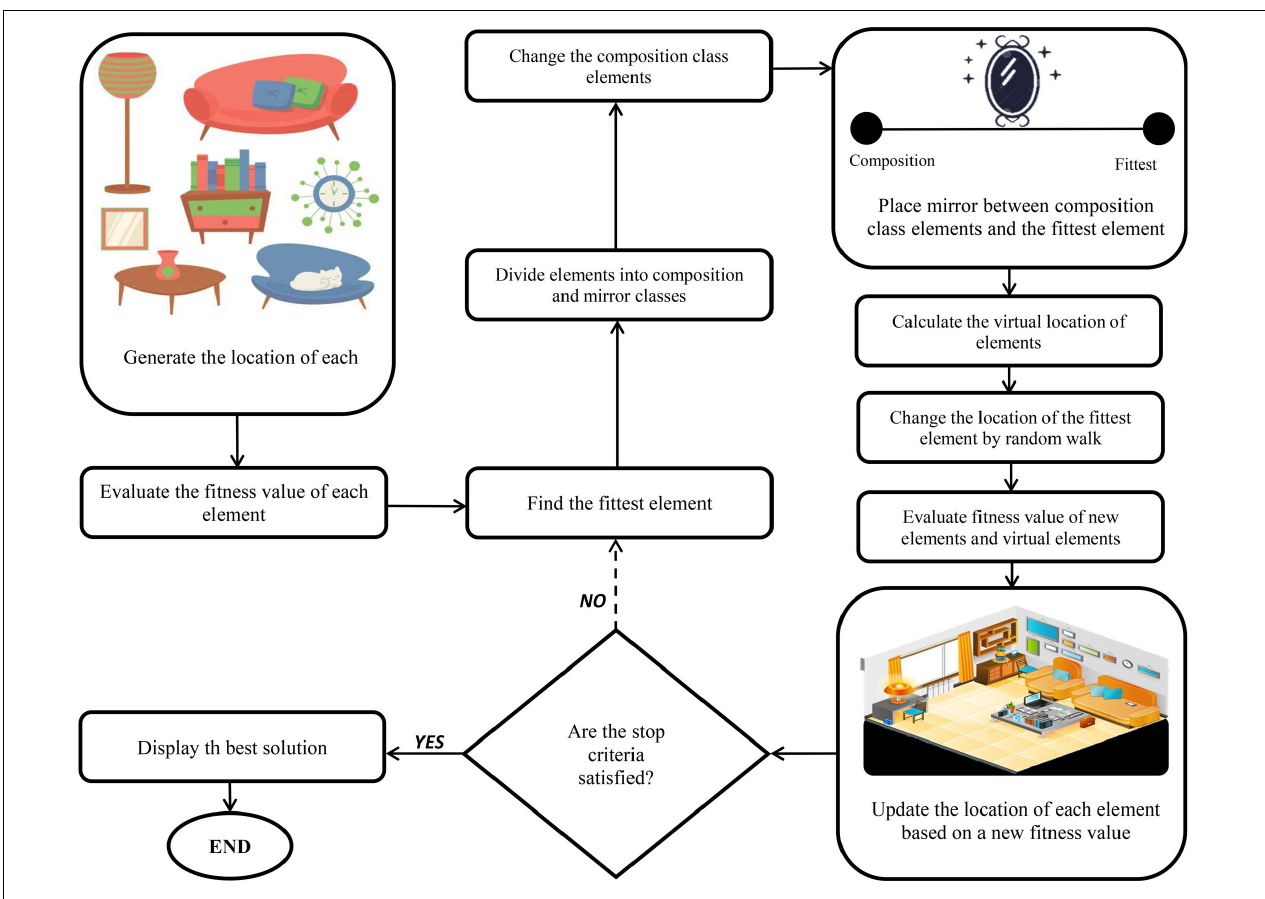
FIGURE 7 | A schematic representation of interior search algorithm